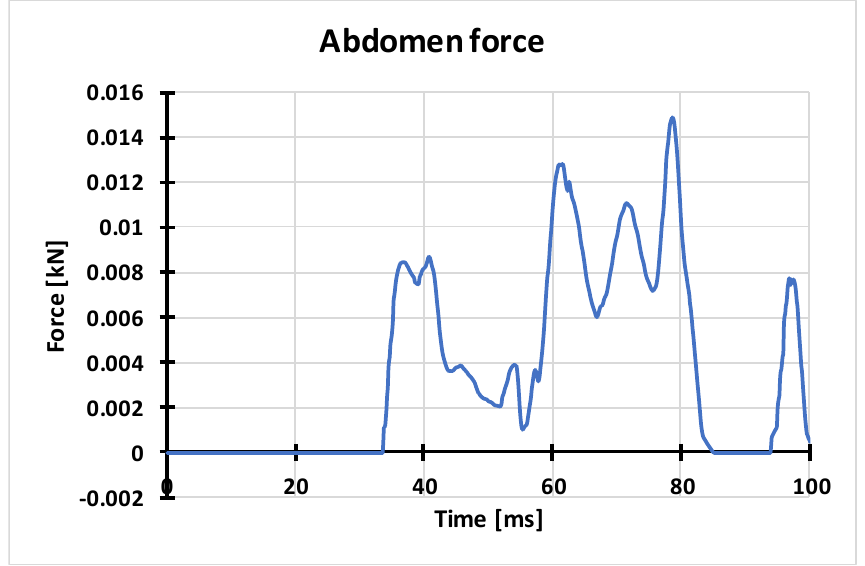
Figure 11. Figure 11. Characteristic of axial force in the dummy's abdomen obtained on the basis of numerical calculations.